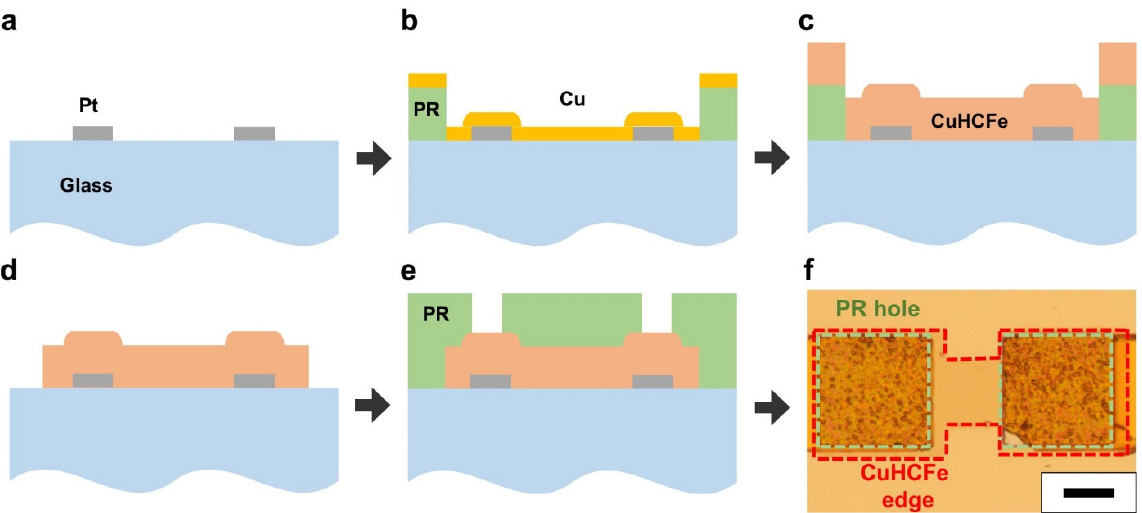
Figure 5. Fabrication process of CuHCFe-based microelectrochemical device: ( a ) Pt electrode patterning, ( b ) photolithogra- phy and copper deposition, ( c ) formation of CuHCFe thin film by immersing into a K 3 Fe(CN) 6 solution, ( d ) removing PR by acetone, and ( e ) passivation by photolithography. ( f ) Optical microscope image of the device. Scale bar: 20 µ m.